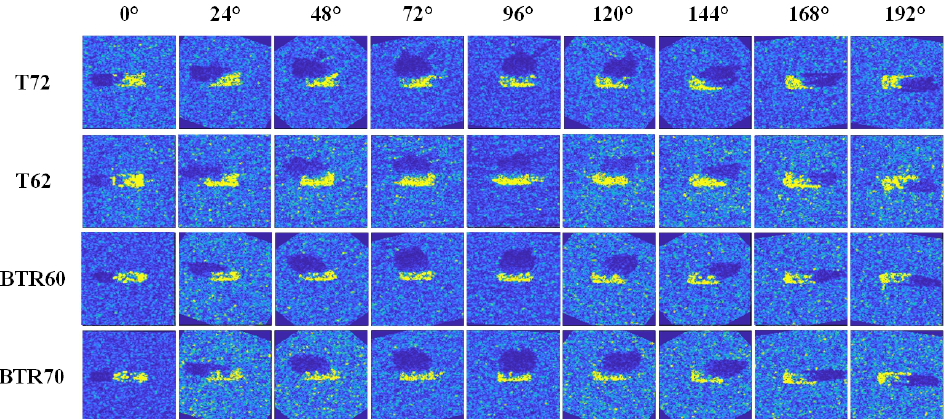
Figure 1. The samples of four categories among the MSTAR SOC under the azimuth-angle normaliza- tion. According to its azimuth angle, the SAR image from each category is selected every 24 degrees. To ensure the continuity of the samples based on azimuth angles, the image of an adjacent azimuth angle is chosen if there is a vacancy of the particular degree